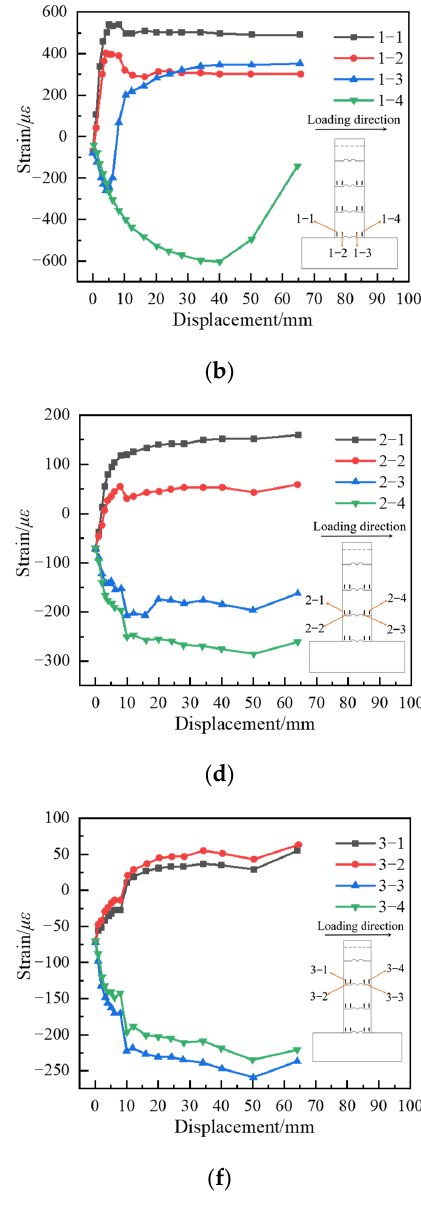
Figure 10. Displacement–strain curves for each section of specimen S1 and S2. ( a ) S1 lower segment. ( b ) S2 lower segment. ( c ) S1 middle segment. ( d ) S2 middle segment. ( e ) S1 upper segment. ( f ) S2 upper segment. After the load level exceeds the peak load, the compressive strain at the edge of the compression zone of the pier bottom section decreases, and the strain distribution of the rest of the cross-section is still in line with the assumption of a flat section. Analysis of the damage phenomena of specimen S1 and specimen S2 found that the column bottom sec- tions of both specimens have a certain degree of bidirectional bending bias load phenom- enon; that is, the neutral axis is not parallel to the rectangular edge of the column cross- section when the section is damaged.